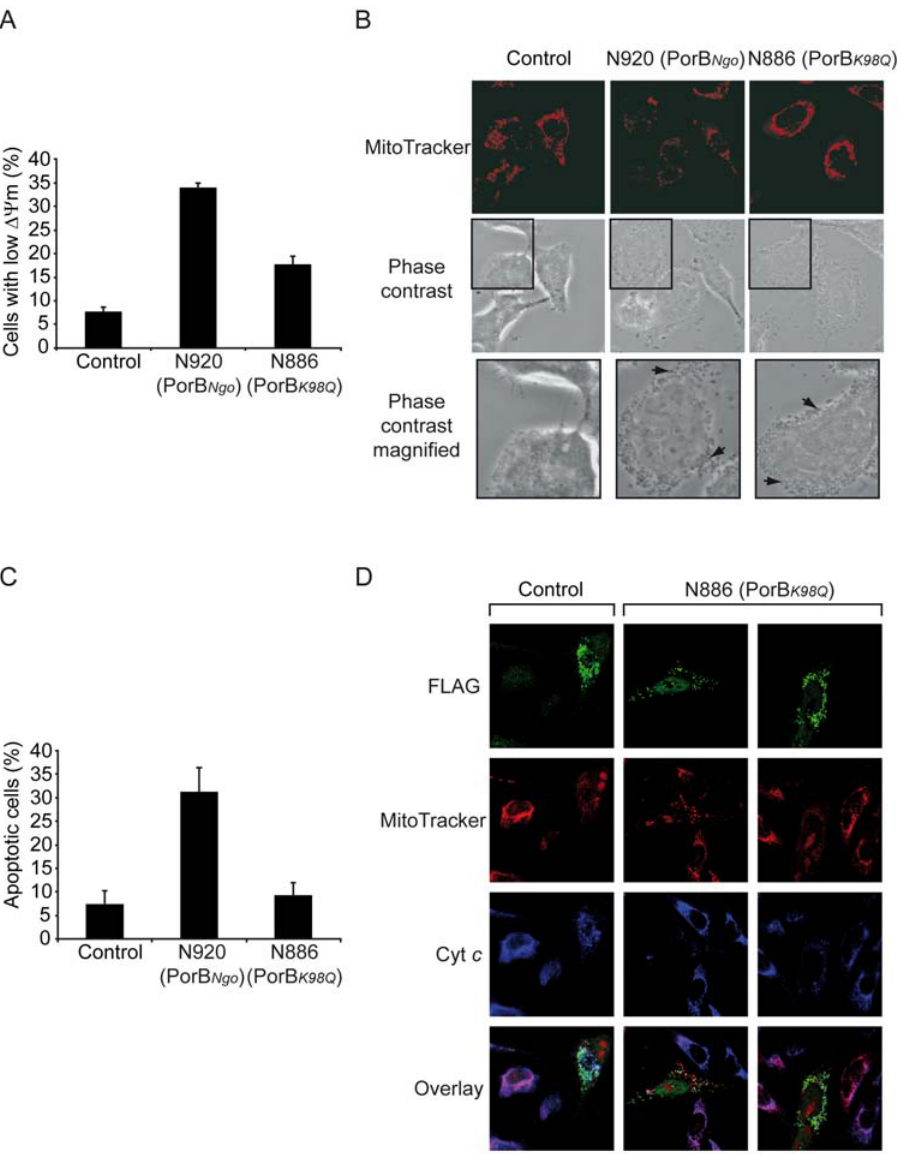
Figure 7. ATP binding is crucial for the PorB-induced DY m loss and apoptosis. ( A ) PorB K98Q is impaired in inducing DY m loss. HeLa cells were infected with the indicated strains N920 (containing wild type PorB Ngo ) and N886 (containing ATP-binding mutant PorB K98Q ), and the loss of DY m was measured using TMRE staining and FACS analysis. The data are expressed as the relative number of cells with low TMRE staining from total cells. Data are mean 6 SD of 3 independent experiments. ( B ) HeLa cells were infected with the indicated strains and DY m was monitored by MitoTracker staining. Phase contrast images demonstrate the strong infection of the HeLa cells. Arrows in the section of magnified phase contrast images point to bacteria. ( C ) HeLa cells were infected with the indicated strains, fixed and stained with 1 m g/ml Hoechst 33342 (Invitrogen) for 10 min followed by intense washing with PBS. A minimum of 200 cells from 5 randomly chosen fields per slide was analyzed for chromatin condensation using a Zeiss immunofluorescence microscope. Data are mean 6 SD of at least three independent experiments. ( D ) FLAG-tagged porin from N. gonorrhoeae (PorB Ngo -FLAG) was expressed in HeLa cells for 24 h prior to infection with strain N886. PorB Ngo -FLAG expression (green), cytochrome c (blue) and MitoTracker staining (red) were monitored. Note that infection with N886 triggered the release of cytochrome c only in cells with PorB Ngo - FLAG expression. Images are representative of three independent experiments.